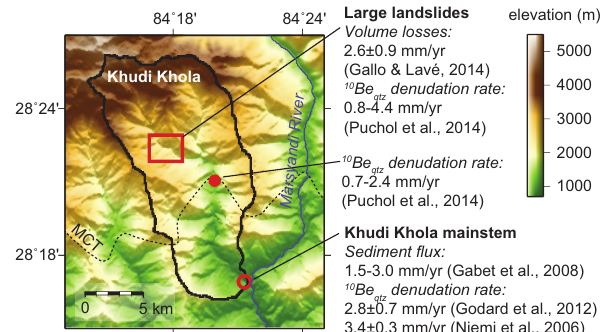
Figure 5. Khudi Khola catchment and reported erosion rates. Back- ground elevation map from SRTM data at 90m resolution; the solid black line is the Khudi catchment boundary and the dashed line (MCT) is the location of the Main Central Thrust from Puchol et al. (2014). Data are shown from a range of studies of both short- and long-term erosion rates in this catchment, which is eroding much more rapidly compared to the Likhu Khola (Fig. 3), is dominated by landslide erosion, and has little agricultural activity compared to the Likhu